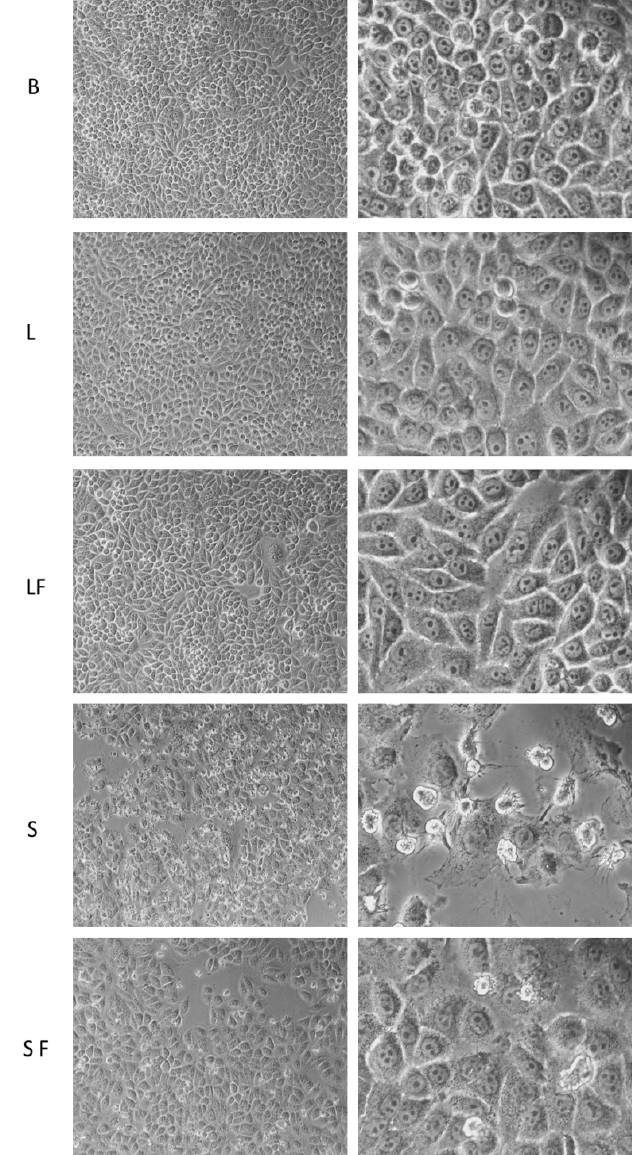
Figure 10. Optical microscope examination of NPs’ effect on T98G cells. NPs without BBR (B, blank), with BBR LAU (L), NPs with BBR LAU and with folic acid coating (LF), NPs with BBR DS (S), and with folic acid coating (SF) were administered (10 7 particles) for 24 h and analyzed using a Nikon TS100 optical microscope at 10× and 40× magnifications.